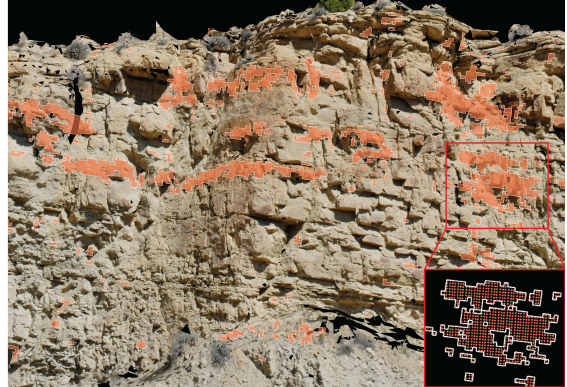
Figure 6. 3D material bodies created using triangulated points and classification boundaries, and superimposed on textured model (Garley Canyon). Inset shows detail of points and lines.